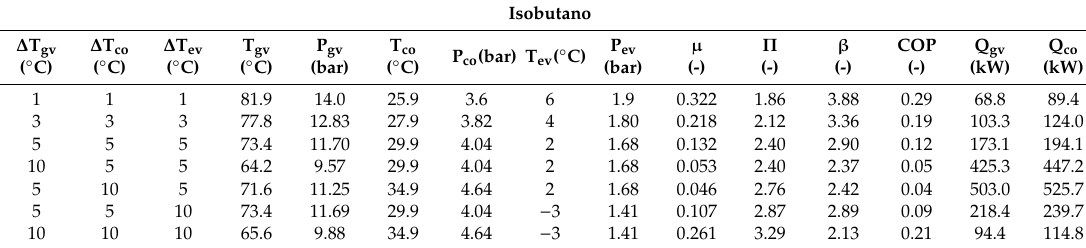
Table A4. Thermodynamic analysis results for Isobutan (R600a).